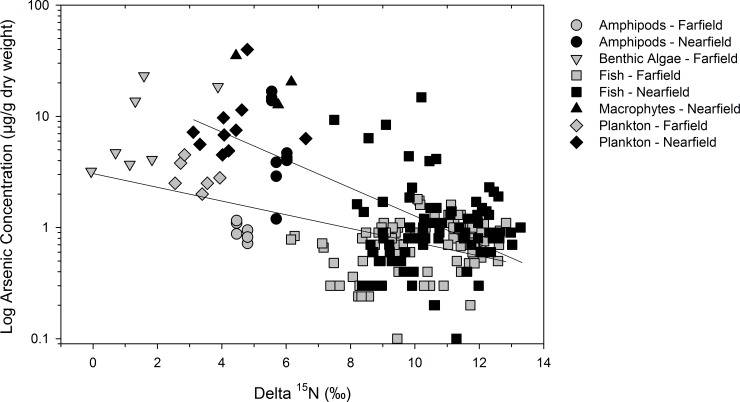
Food web total arsenic concentrations in relation to trophic position (δ15N).Lower trophic level biota (benthic primary producers, plankton, and amphipods) and fishes are identified separately, as are data for the nearfield and farfield areas in Great Slave Lake, Northwest Territories, Canada. The GLM was statistically significant (r2 = 0.41, F = 51, p < 0.001, n = 217), and the regression slope for nearfield biota was significantly steeper (p < 0.001) than for the farfield area. The y-axis is presented on a logarithmic scale.